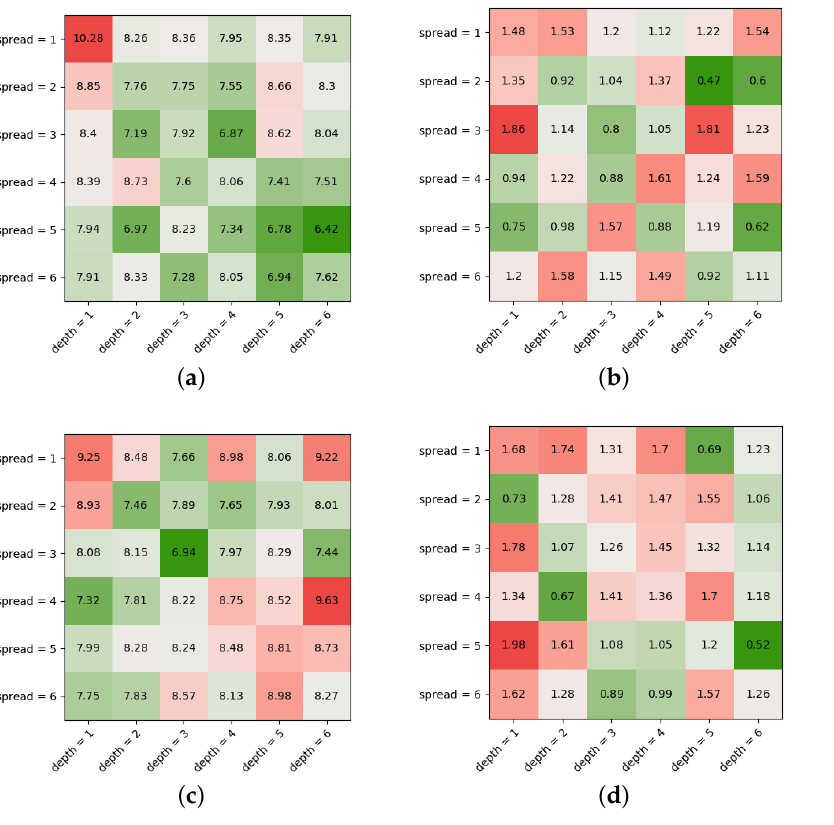
Figure 3. Model Shape Optimization. ( a ) Optimizer = Adadelta; Average, Relative RMSE for Model Spread and Depth (%); ( b ) Optimizer = Adadelta; Average, Relative SD for Model Spread and Depth (%); ( c ) Optimizer = RMSProp; Average, Relative RMSE for Model Spread and Depth (%); ( d ) Optimizer = RMSProp; Average, Relative SD for Model Spread and Depth (%) MSE arr as prediction quality ( c ) and its SD ( d ) in dependence of f ModelSpread and n ModelDepth for the Adadelta (best case) and the RMSProp algorithm (worst case); values are scaled for better readability [Abbreviations: RMSE = Rooted Mean Square Error; SD = Standard